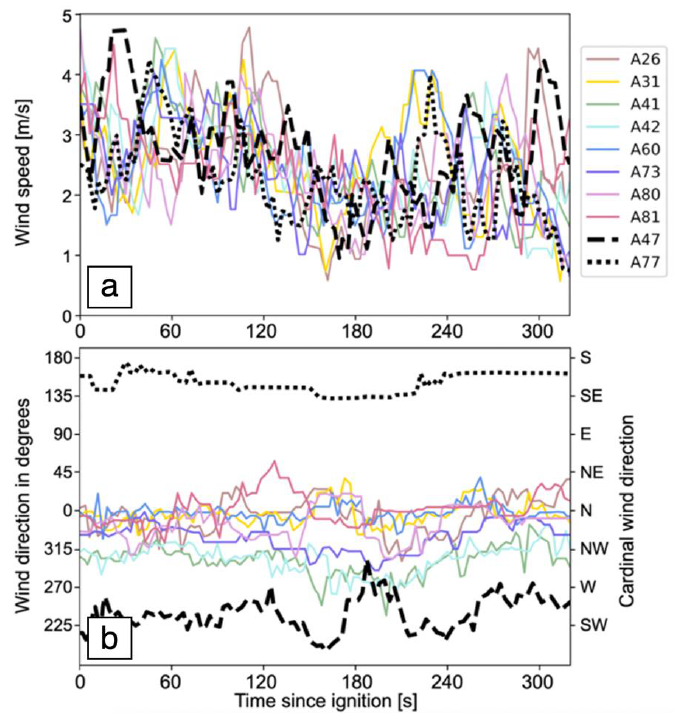
Figure 4. Wind speed ( a ) and direction ( b ) measured in 3 s intervals for the 10 upwind anemometers. A47 and A77 (black, bold lines) were excluded from the analysis because their measurements of wind direction differ substantially from the remaining sensors. These anemometers are marked with red circles in Figure 3.